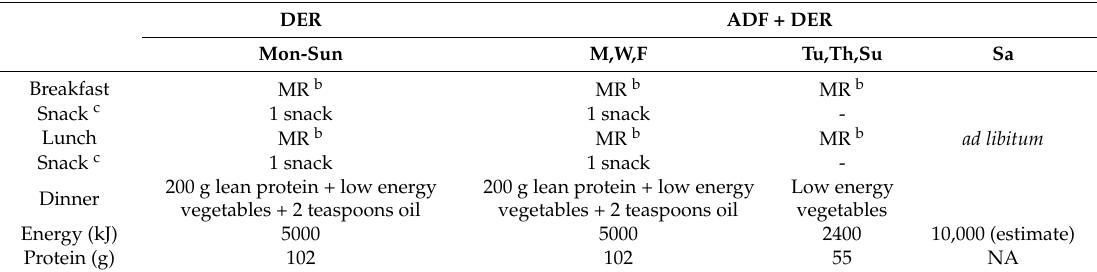
Table 1. Summary of the continuous energy restriction meal replacement program a (DER) and alternate day fasting meal replacement program (ADF + DER) dietary